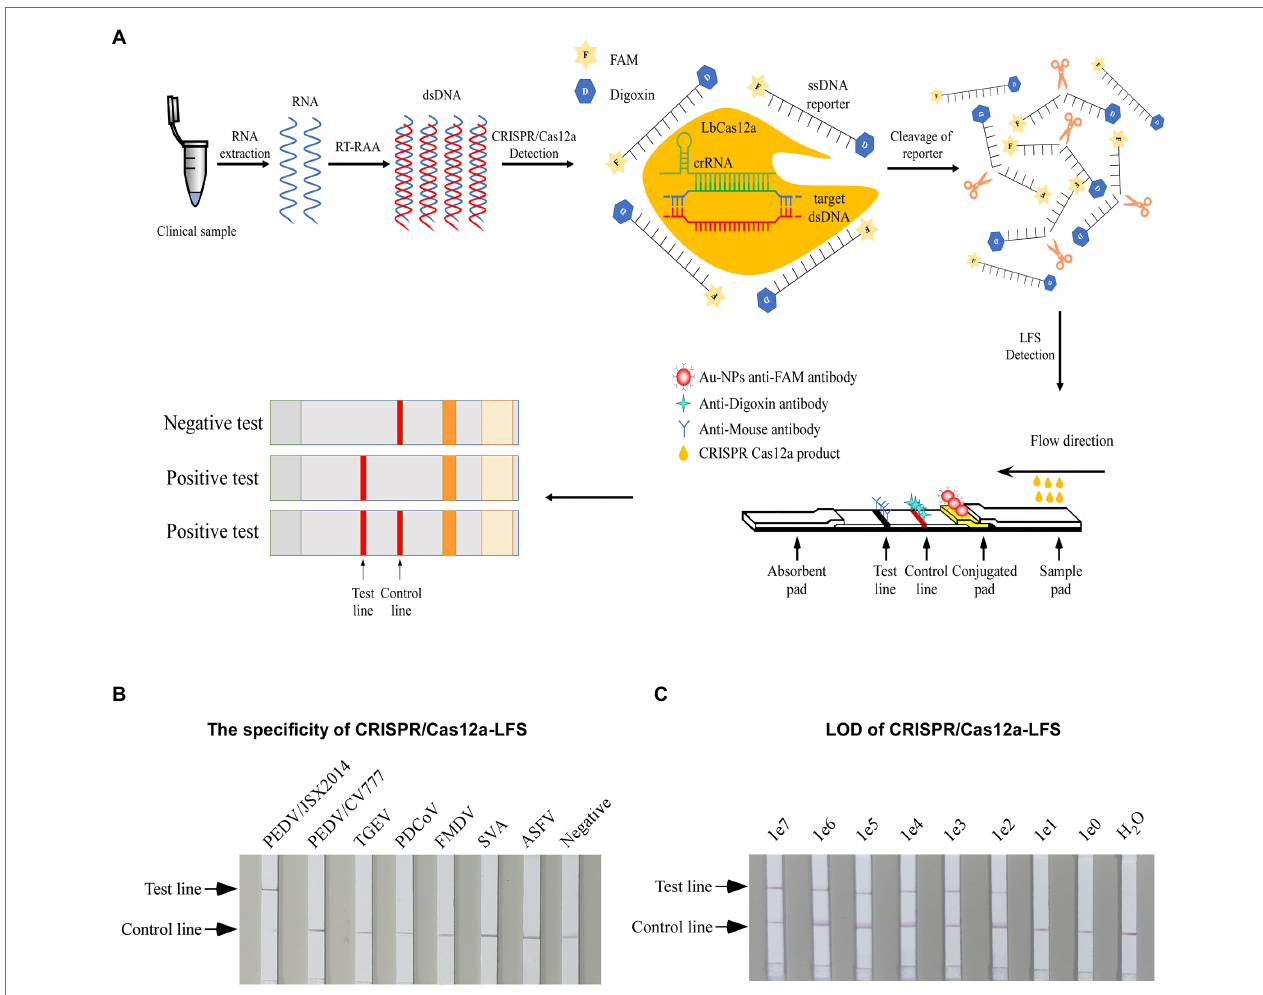
FIGURE 1 | Establishing the CRISPR/Cas12a-LFS. (A) Schematic diagram of PEDV visual detection, the method combines RAA assay, the CRISPR/Cas12a-FDS, and lateral flow strips (LFSs). The ssDNA reporter was labeled with FAM and digoxin (ssDNA-FD-reporter) at the 5 ́′ and 3 ́′ termini, respectively. The immunochromatographic strip using Au-NPs anti-FAM antibody to show the readout. The sample band was only shown when the ssDNA-FD-reporter was cleaved by CRISPR/Cas12a, which is activated by PEDV cDNA. Both the control line and the test line showed when the ssDNA-FD-reporter was partially cleaved, and only the test line showed when the ssDNA-FD-reporter was completely cleaved. (B) The specificity of different porcine viruses was detected by CRISPR/Cas12a-LFS. (C) The LOD of PEDV S gene was detected by CRISPR/Cas12a-LFS. Serially diluted synthetic pUC57-PEDV-S was used as the